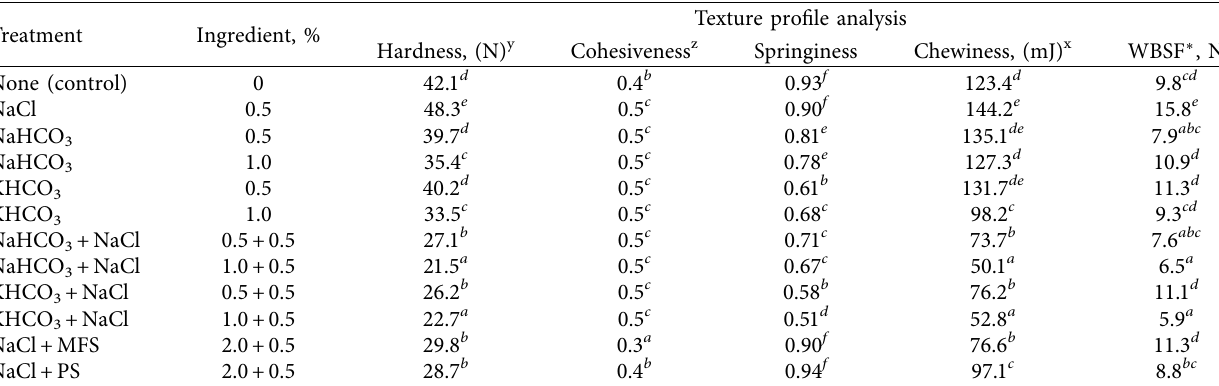
Table 4: Least-squares means for texture profile analysis (TPA) chewiness, hardness, and cohesiveness values of cooked ground beef treated with differing levels of sodium bicarbonate, potassium bicarbonate, salt, modified food starch, and potato starch.